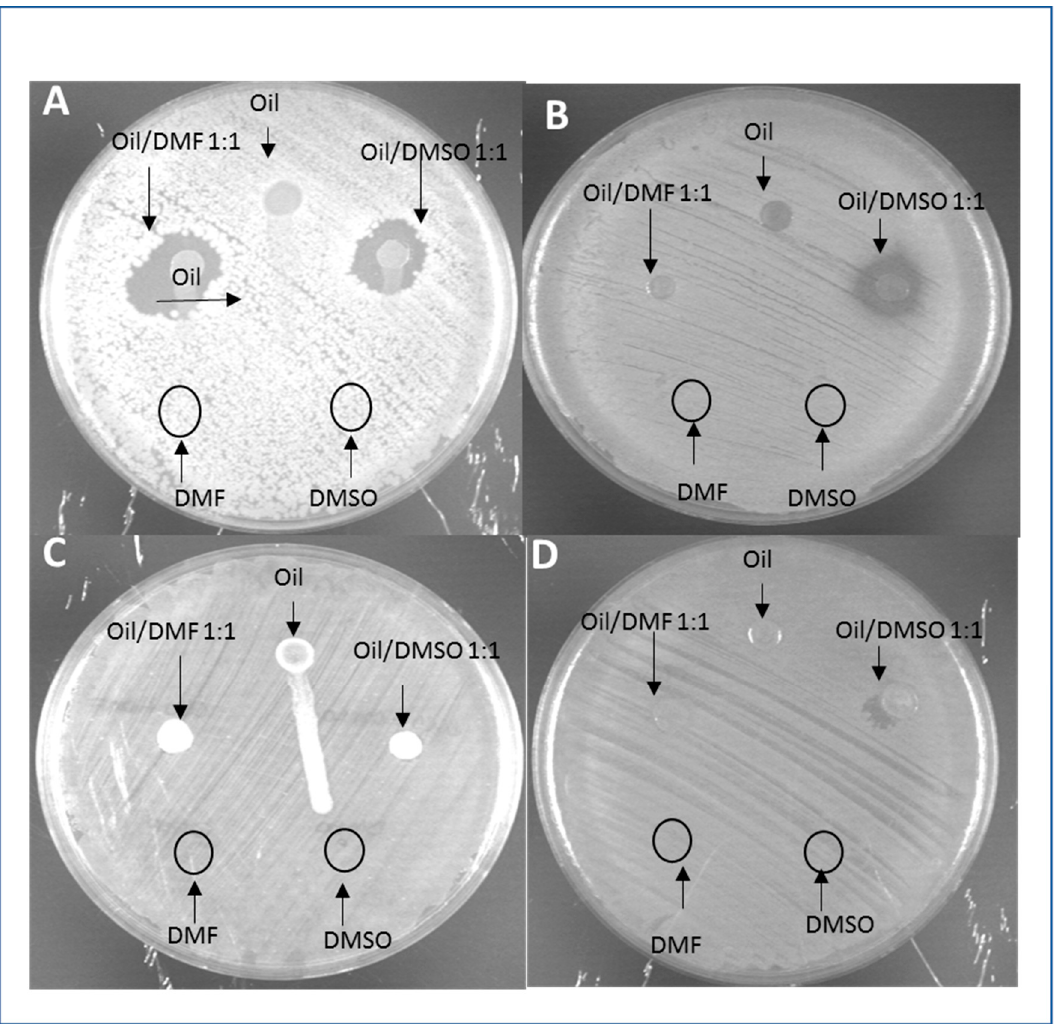
Figure 2. Representative images of agar diffusion tests. Samples of B. mori oil or B. mori oil mixed 1:1 with dimethylsulfoxide (DMSO) or N,N -dimethylformamide (DMF) were loaded on LB agar plates inoculated with B. subtilis ( A ), S. aureus ( B ) E. coli ( C ), and P. aeruginosa ( D ). Upon 24-h growth, inhibition halos were observed and measured.